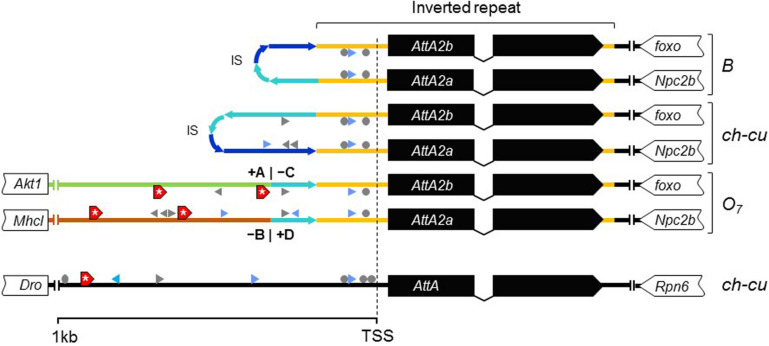
New dFOXO binding sites. Schematic representation of up to 1-kb sequence up and downstream predicted TSSs of AttA and the inverted duplicates of AttA2 (represented as in Figure 6) in O7 and the uninverted (B and ch-cu) states, including also the nearest flanking genes. Colored lines connecting genes designate the following: orange, region of the inverted repeats; dark and light blue, first and second halves of the spacer of the inverted repeats, respectively, oriented as the arrowheads; green and brown, the novel sequences to which the AttA2 copies became reattached by O7, with corresponding breakpoints (+A|−C and −B|+D) indicated. The inverted repeats of B and ch-cu are folded over each other. Putative TFBs are symbolized: gray arrowheads and circles (palindromic sites), for Dorsal, Relish, and Diff/Relish; blue arrowheads for Serpent, and red boxes with an asterisk for dFOXO, respectively. Only AttA and the two Att2A copies of O7 have TFBs for dFOXO.